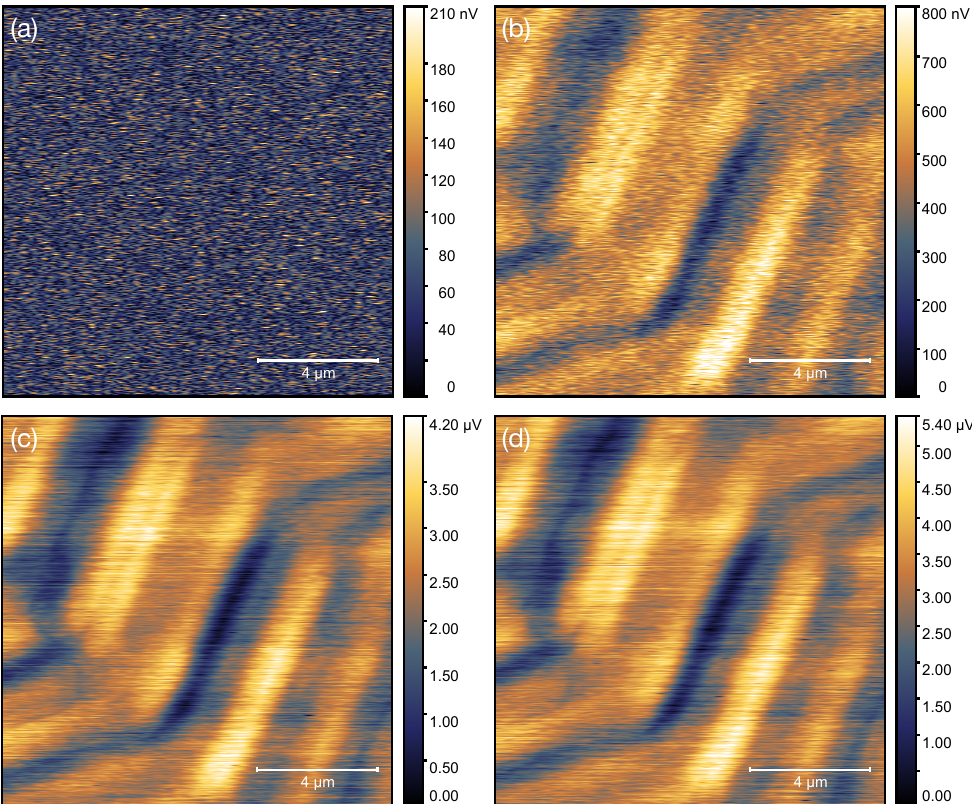
Figure 6. ( a – d ) SHPM images recorded with the GFM Hall sensor shown in Figure 5. The ac reference current is increased from 0 µ A in ( a ), over 10 µ A in ( b ) and 70 µ A in ( c ) to 95 µ A in ( d ) resulting in an increase in the Hall voltage contrast (see color bar range). Because of non-ideal offset voltage compensation, the smallest Hall voltage measured in each scan was used as reference voltage and set to zero in defining the image contrast scale. The sensor was taken from a batch of sensors written under identical conditions for which we measured representative calibration factors of 2.7nV/(mT µ A) ( ± 10%). See text for details.